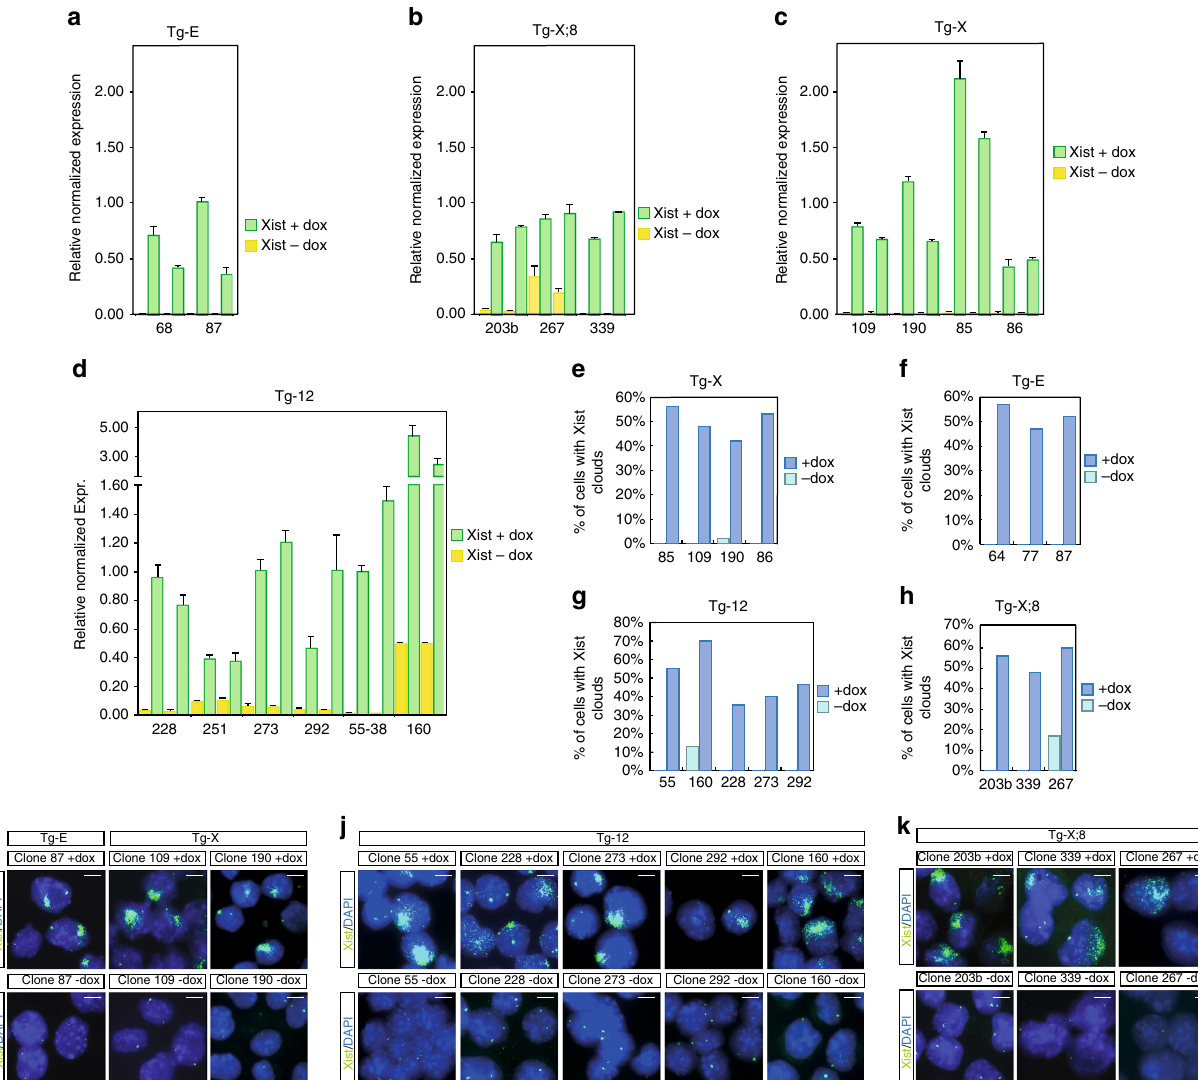
Fig. 2 Ectopic Xist RNA induction in undifferentiated ES cells. qPCR quanti fi cation of Xist RNA in clones a Tg-E (68, 87), b Tg-X;8 (203b, 267, 339), c Tg-X (109, 190, 86, 85), and d Tg-12 (228, 251, 273, 292, 55-38, 160) after 5 days of doxycycline treatment. Data of two independent experiments are shown ( e – h ). Quanti fi cation of Xist RNA FISH experiments in clones Tg-X (85, 109, 190, 86) e , Tg-E (64, 77, 87) f , Tg-12 (55, 228, 273, 292, 251) g , and Tg-X;8 (203b, 339, 267) h after 5 days of doxycycline induction. n > 100 nuclei counted per ES clones. i – k Representative images of Xist RNA FISH analysis of clones Tg-E (87), Tg-X(109), Tg-X;8 (203b, 339), and Tg-12 (55, 228, 273, 292) after 5 days of doxycycline treatment. Xist, FITC; DNA is stained with DAPI ( blue ). Scale bars represent 5 μ